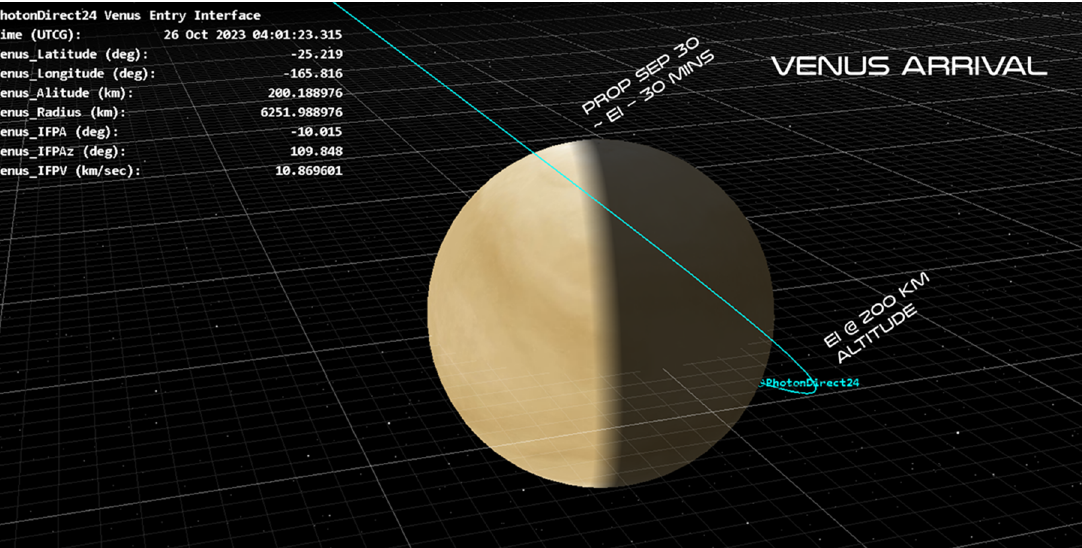
Figure 5. High-energy Photon bus releases the entry probe 30 min before entry interface (EI) after targeting the entry interface selected for optimal instrument measurement conditions.